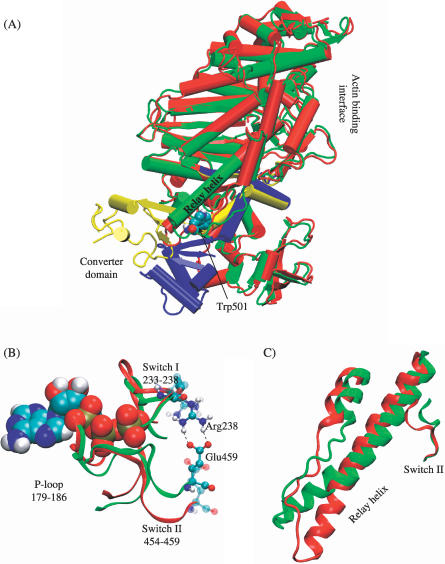
Structural Differences between Conformations of the D. discoideum Myosin Motor Domain(A) The difference between the post-rigor (1FMW [18]) and pre-powerstroke (1VOM [19]) states. The structures are aligned based on backbone atoms in the first 650 residues; red and blue correspond to 1FMW, green and yellow correspond to 1VOM. Trp501 is shown in the van der Waals form.(B) Superposition of the active-site region in 1FMW and 1VOM (same color coding as in (A); the nucleotide is shown in the van der Waals form).(C) Superposition of the relay helix and relay loop in 1FMW and 1VOM with the same color coding as in (A).